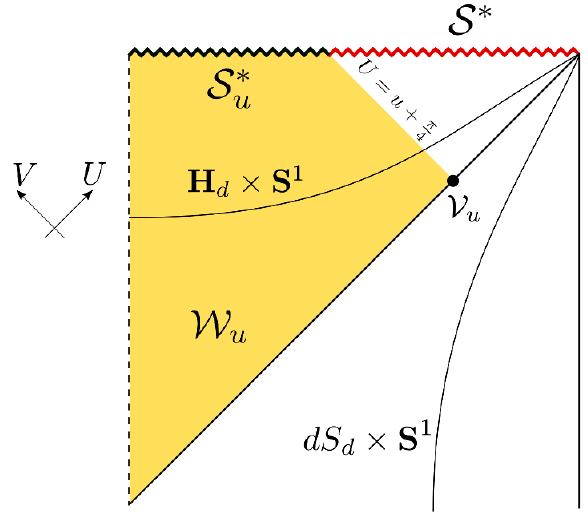
Figure 12 . The causal structure of the topological crunch singularity and its associated WdW patches. The projection of W u onto the ( U, V ) plane is shown as the yellow sector in the figure, and coincides with the domain of integration W ( U, V